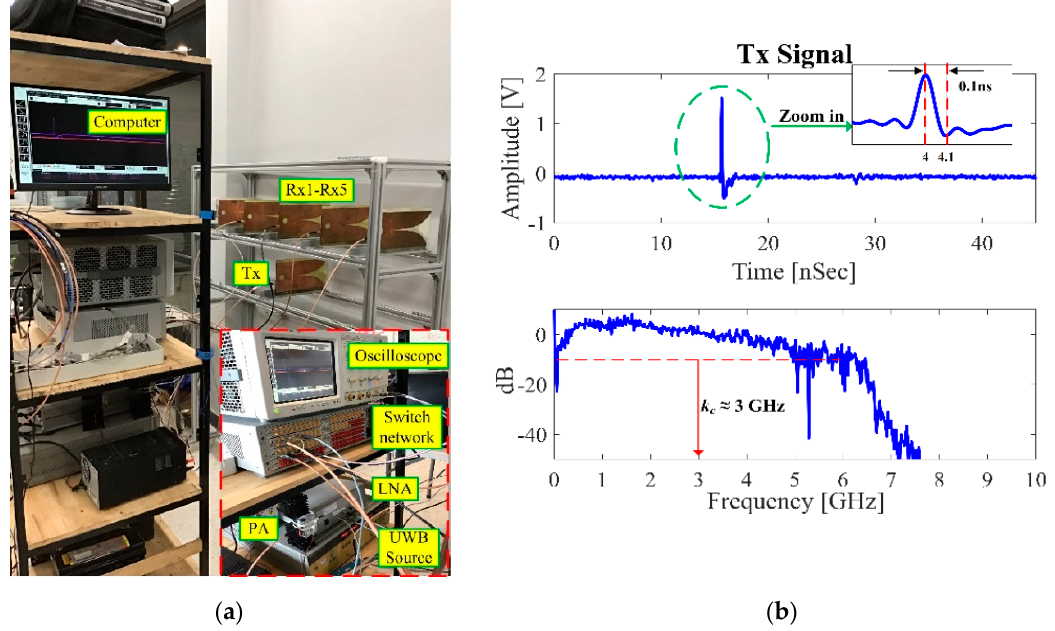
Figure 8. ( a ) Experimental setup of the switched-antenna-array radar prototype. The space between receiving antennas (Rx1–Rx5) is 30 cm; ( b ) the UWB signal of the transmitting antenna (Tx). Table 3. Descriptions of the experimental hardware.